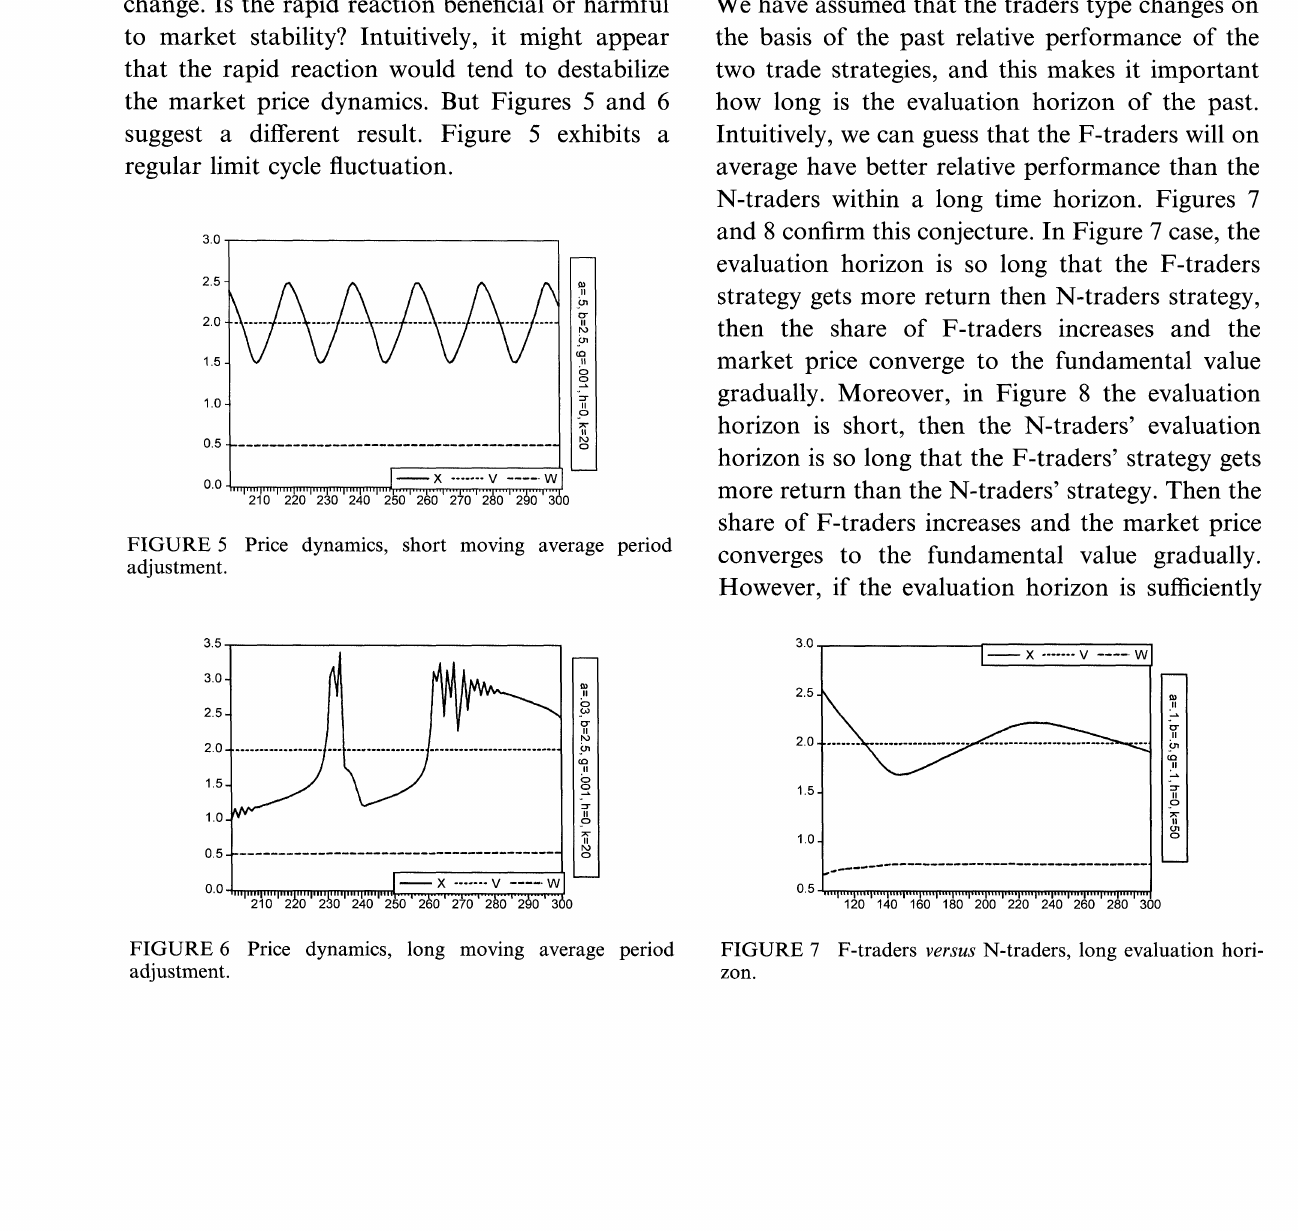
FIGURE 7 F-traders versus N-traders, long evaluation hori-